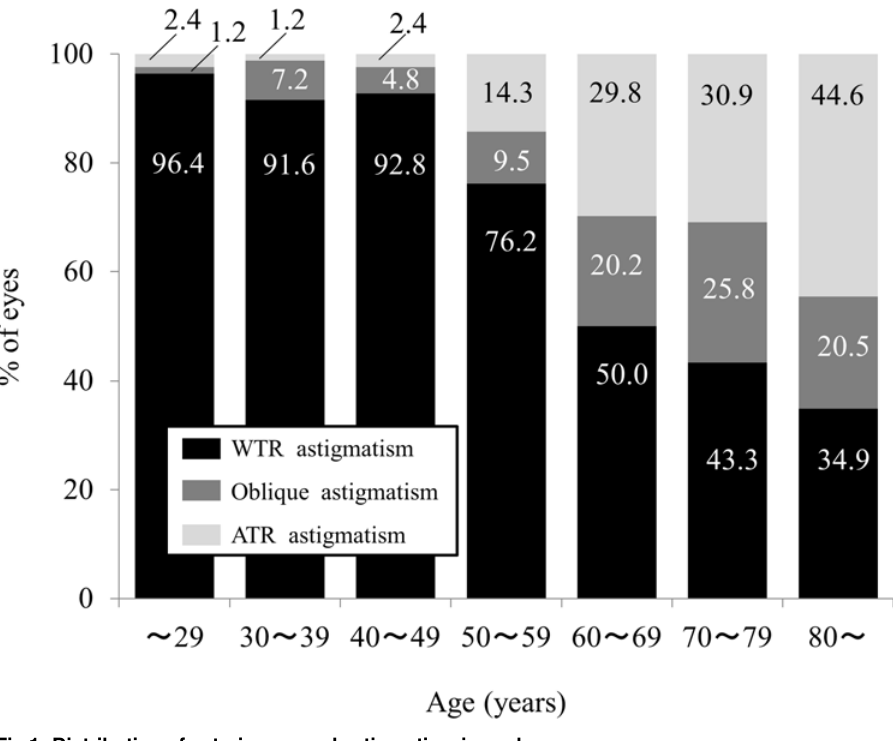
Fig 1. Distribution of anterior corneal astigmatism in each age group.